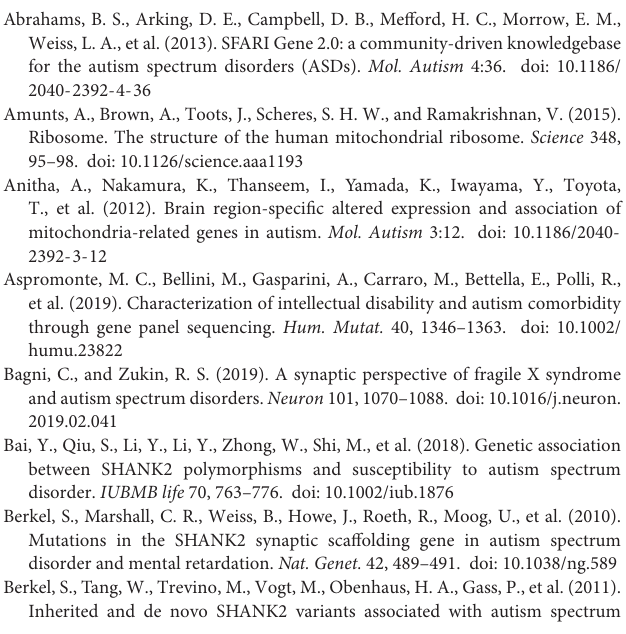
Supplementary Table 8 | Details on the top enriched gene sets in C5 subdomains (CC, BP, and MF) for W3-HT, W3-HM, W12-HT, and W12-HM transcript groups, showing information on individual genes contributed to the enrichments such as original rank and running enrichment score. Supplementary Table 9 | ASD-related/risk and cell-type-specific gene sets used for GSEA of Shank2 -mutant transcript groups (W3-HT, W3-HM, W12-HT, and